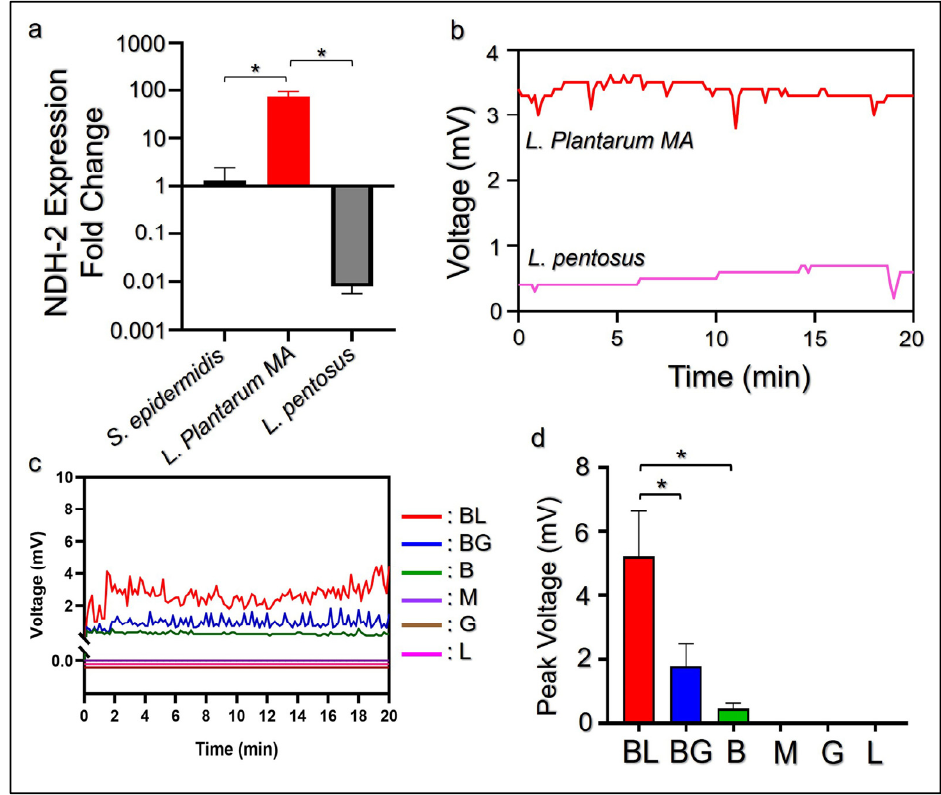
Figure 2. Assessment of the electrogenic property of L. plantarum MA. ( a ) NDH-2 expressions of the S. epidermidis , L. plantarum MA and L. pentosus represented by fold change. ( b ) The pattern of electricity production of L. plantarum MA and L. pentosus which were treated with 2% lactulose within 20 min. ( c ) The pattern of electricity production generated from the MRS (B), MRS + 2% glucose (G), and MRS + 2% lactulose (L), or that were generated from L. plantarum MA treated with MRS (B), MRS + 2% lactulose (BL), or MRS + 2% glucose (BG) within 20 min. ( d ) The average peak voltage of each group shown in ( c ). Values are the mean ± SD (n = 3). * p < 0.05.